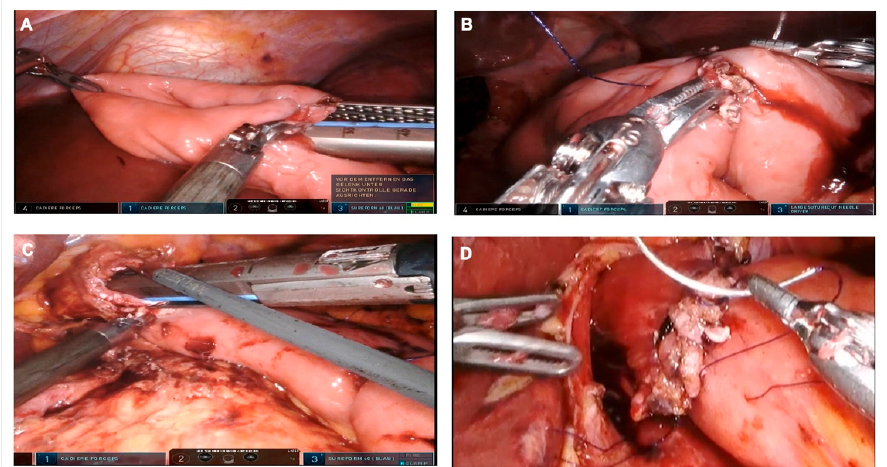
Figure 4. Jejunal pouch reconstruction. ( A ) A jejunal pouch is produced using an endoscopic stapler, two to three cartridges are usually required. ( B ) Closure of the enterotomy at the aboral (distal) end of the pouch. ( C ) Creation of the posterior wall of the esophagojejunostomy using a linear stapler. ( D ) The anterior wall of the esophagojejunostomie is created by means of barbed sutures.